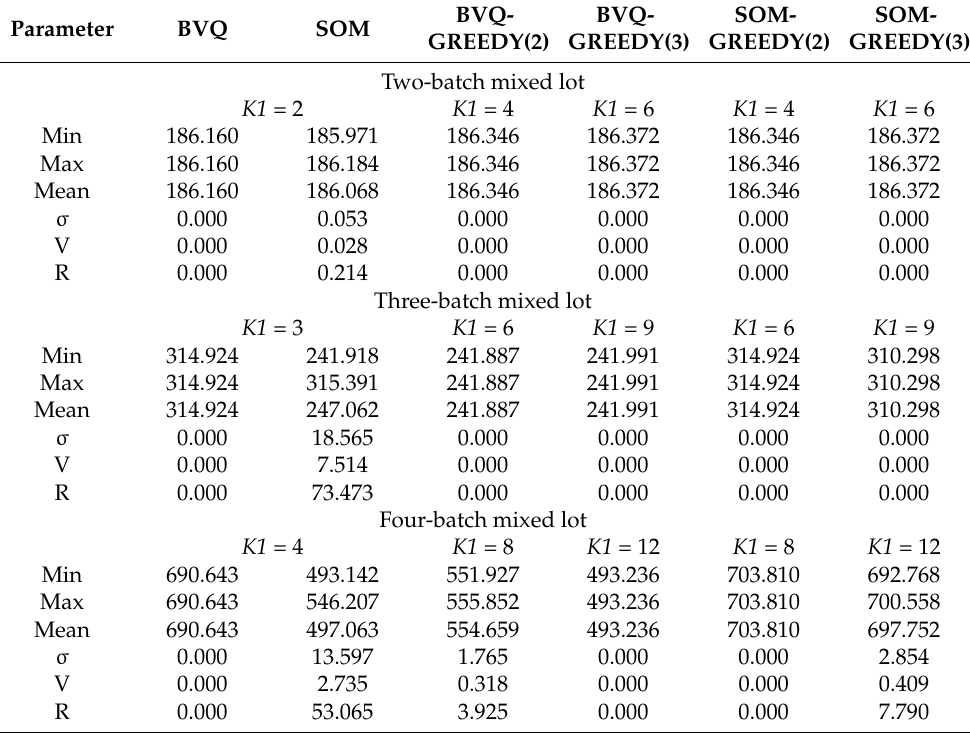
Table A13. Objective function value summarized after 30 attempts (Manhattan distance, initialization by average).